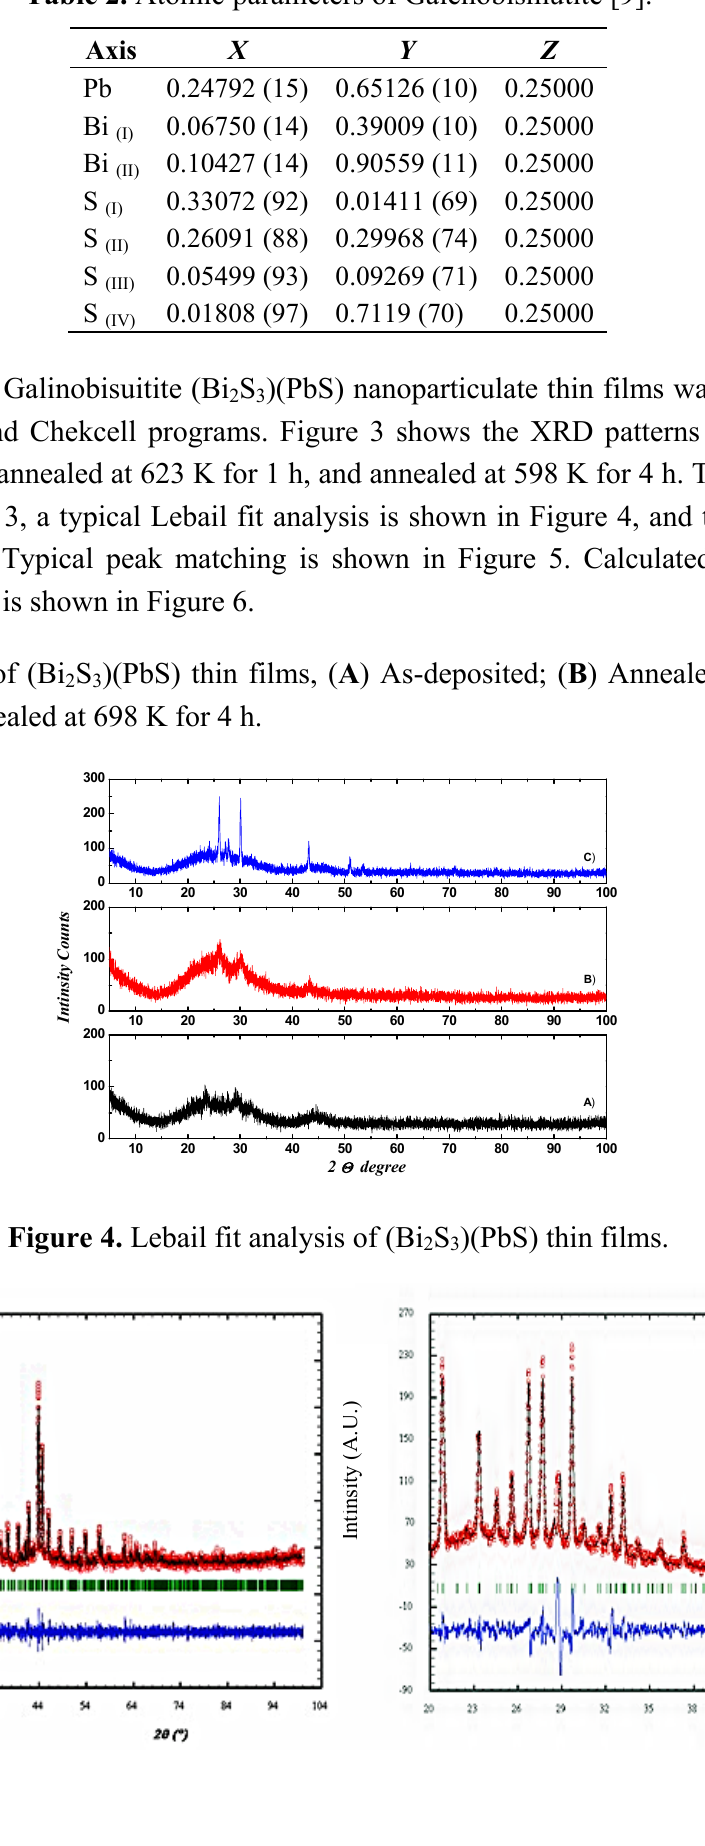
Table 2. Atomic parameters of Galenobismutite [9].